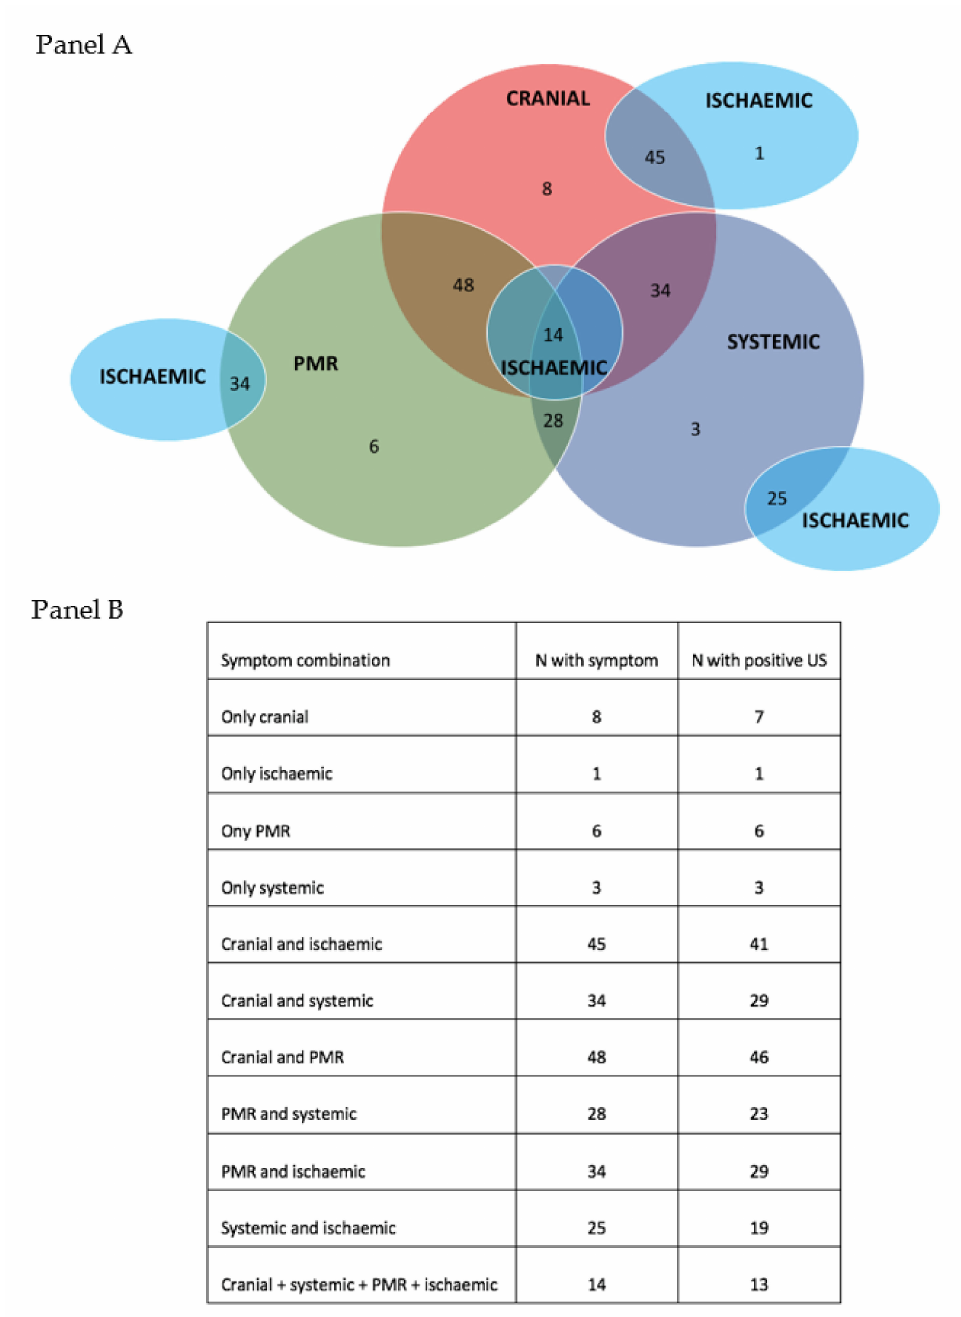
Figure 2. Clinical presentation, symptoms overlap, and corresponding ultrasound findings in patients with GCA. Panel A: overlap of presenting symptoms in patients referred to the fast-track clinic and receiving a final diagnosis of GCA. Panel B: number of patients with a positive ultrasound according to the different types of clinical